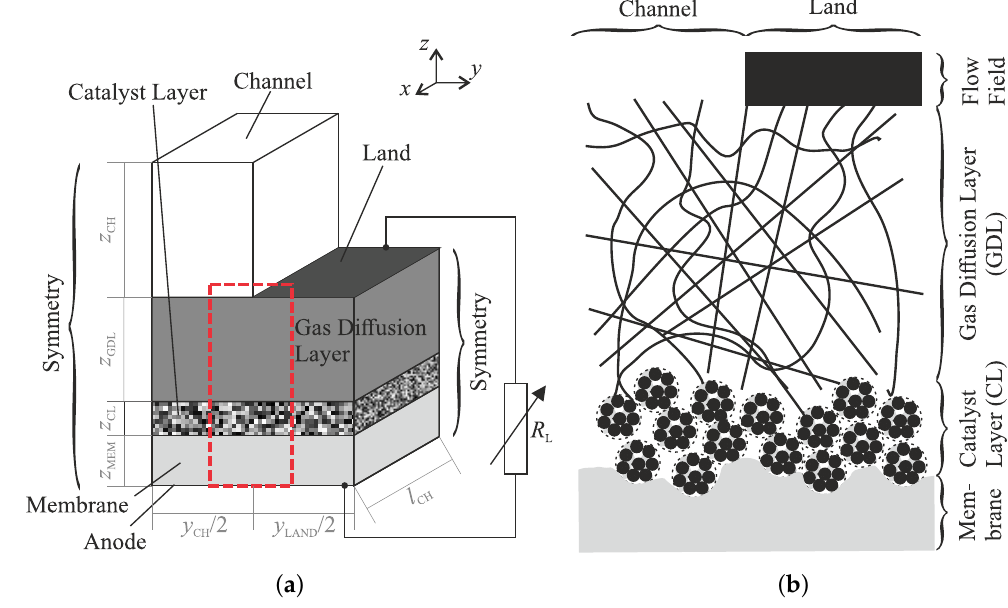
Figure 5. ( a ) Representation of the simulated domain. Boundaries are indicated, the highlighted area is shown in detail in ( b ) Schematic representation of the different layers on the cathode side of a PEMFC.